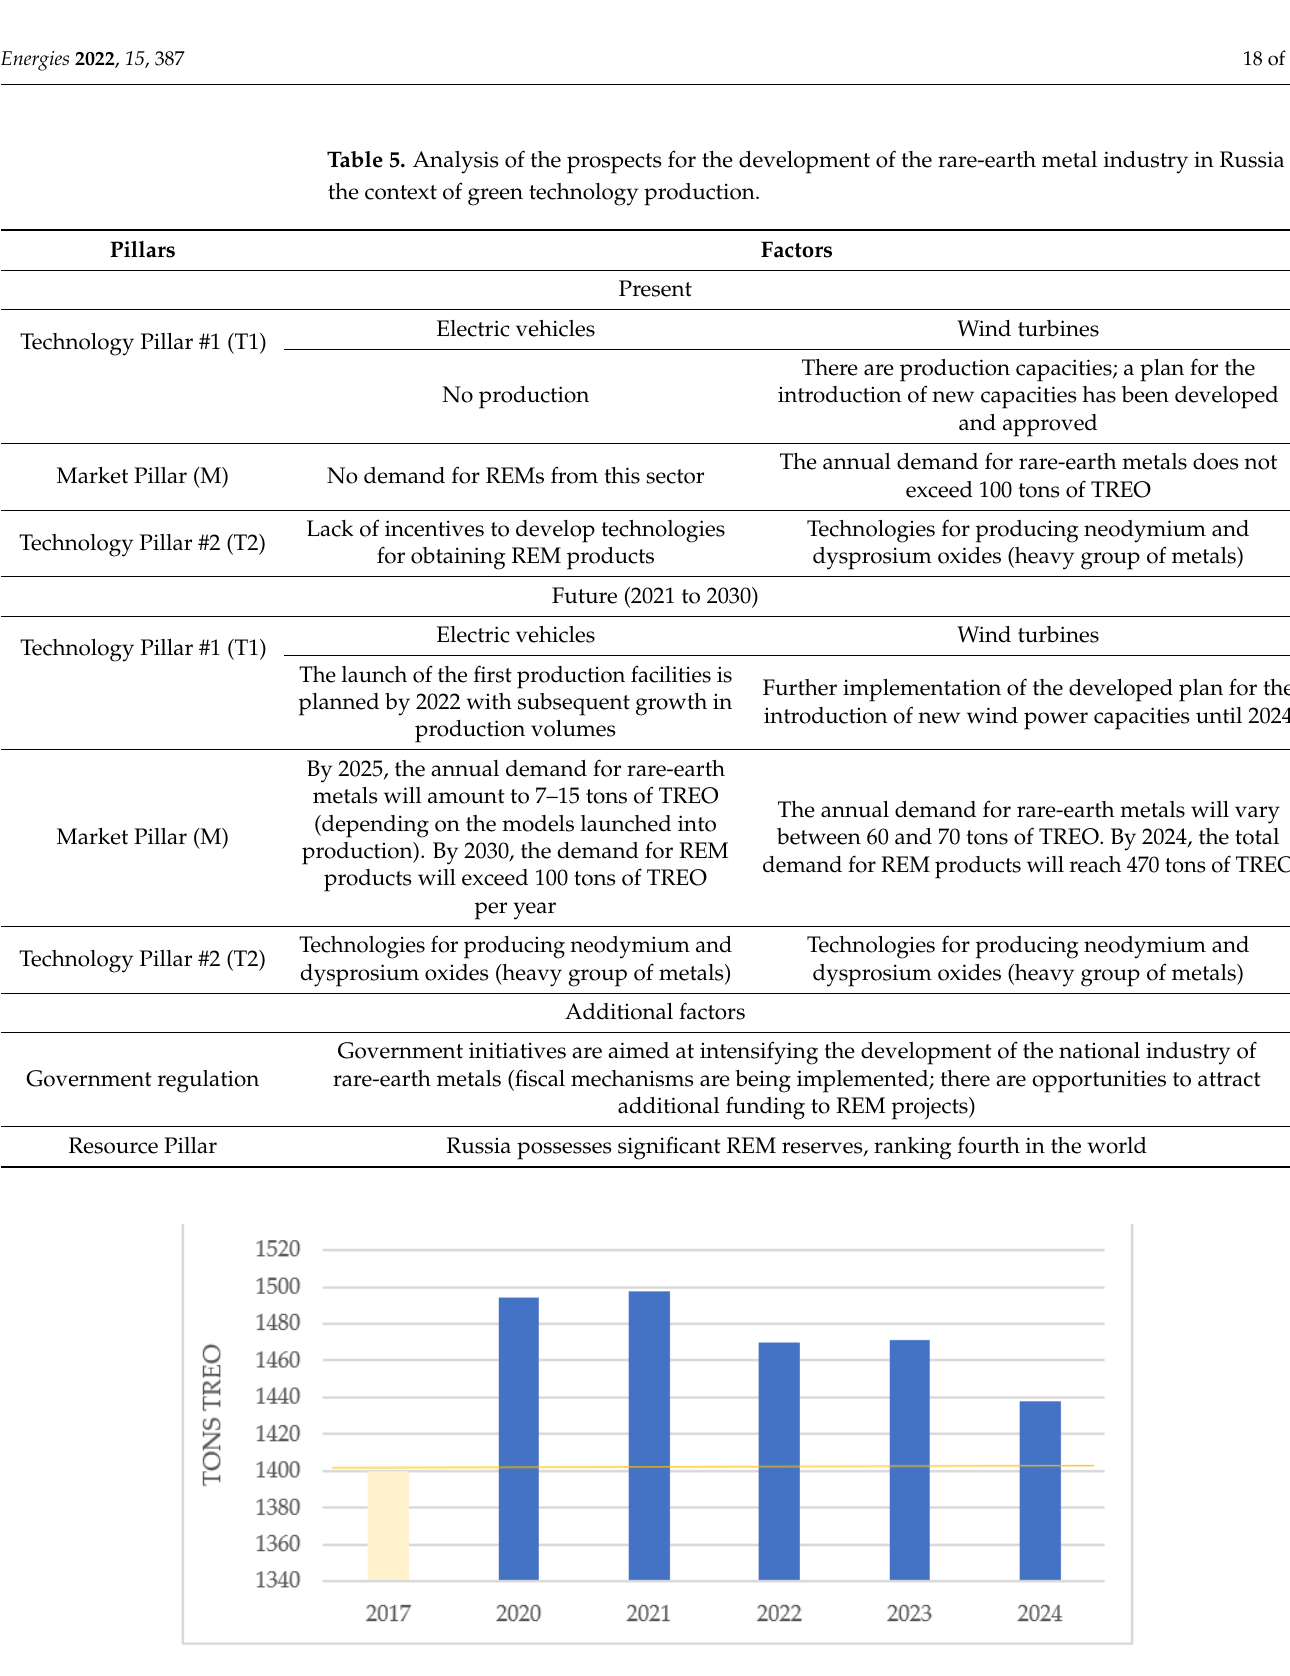
Figure 9. Forecasts for the increase in demand compared to the baseline indicator (if the plans associated with wind farms and electric vehicles are fulfilled), tons TREO.